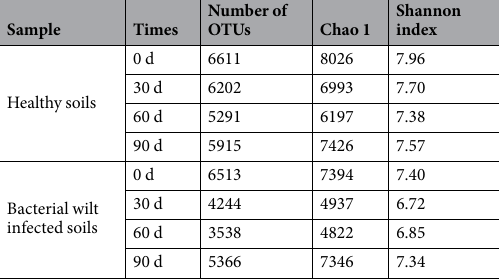
Table 4. Number of OTUs and alpha diversity of bacteria.